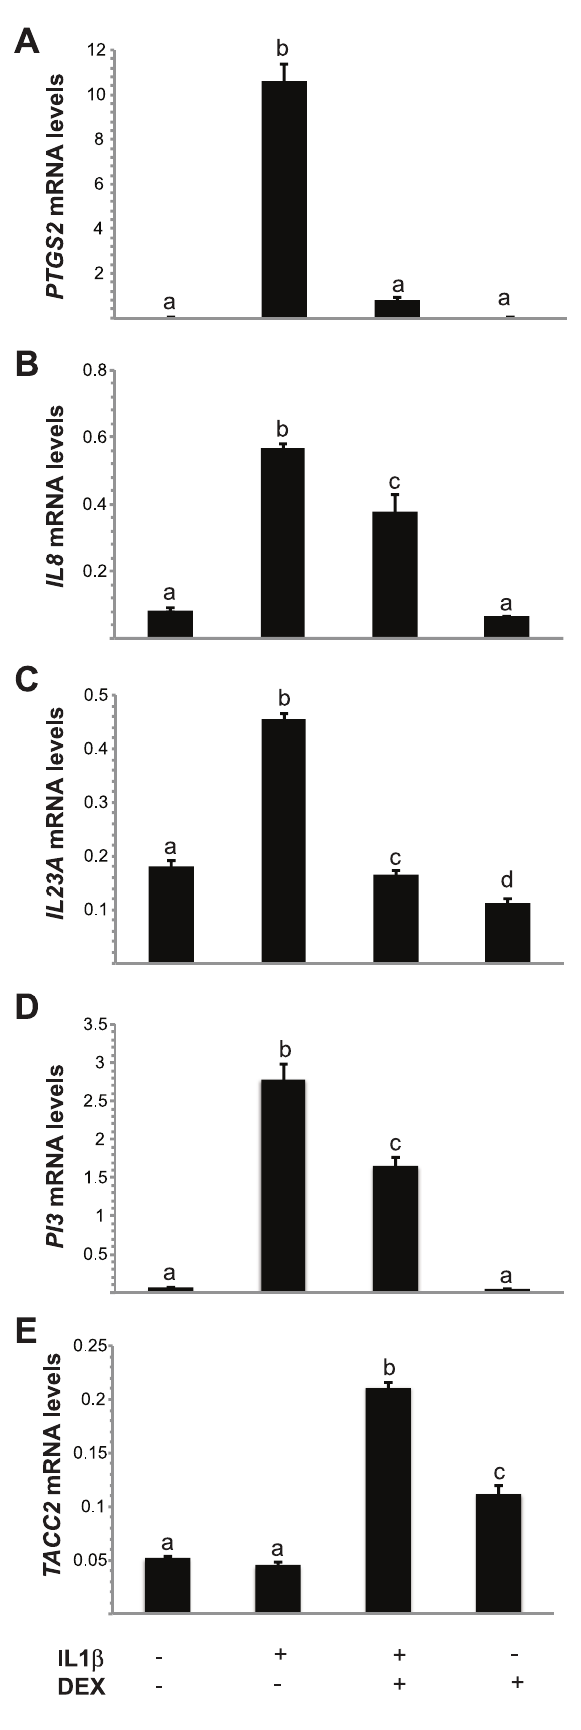
Figure 6. Transcript levels of PTGS2 , IL8 , IL23A , PI3 and TACC2 following IL1 b and/or DEX treatment. Primary FTE cells were treated with 10 nM DEX or vehicle 30 h prior to treatment with 50 ng/ ml IL1 b or vehicle and harvested 18 h later. Total RNA was extracted and RT-qPCR was performed for PTGS2 (A), IL8 (B), IL23A (C), PI3 (D), TACC2 (E) and were normalized to the geometric mean of 4 reference genes. Bars represent the mean 6 SEM (n=3). Bars with different letters are statistically different from one another as determined by ANOVA followed by a Student-Newman-Keuls post-hoc multiple comparison test ( p ,